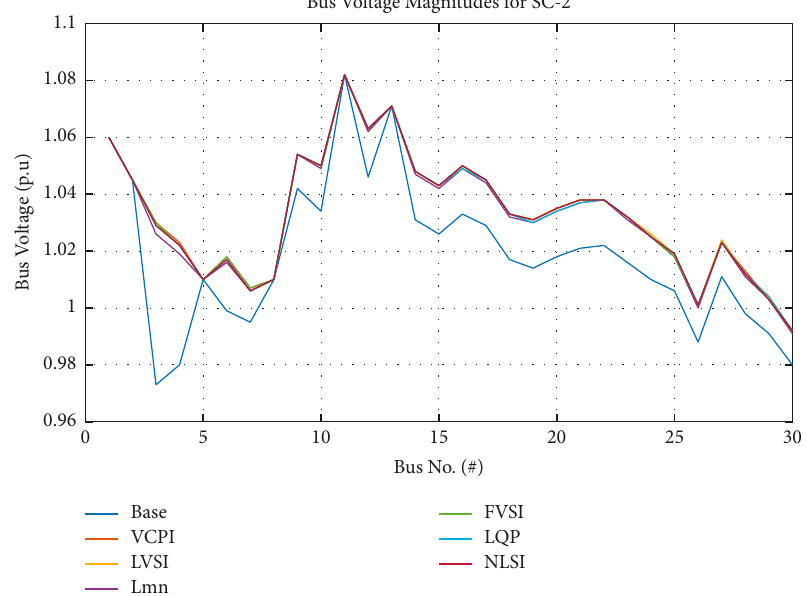
Figure 12: SC-2 bus voltage magnitudes for the different case